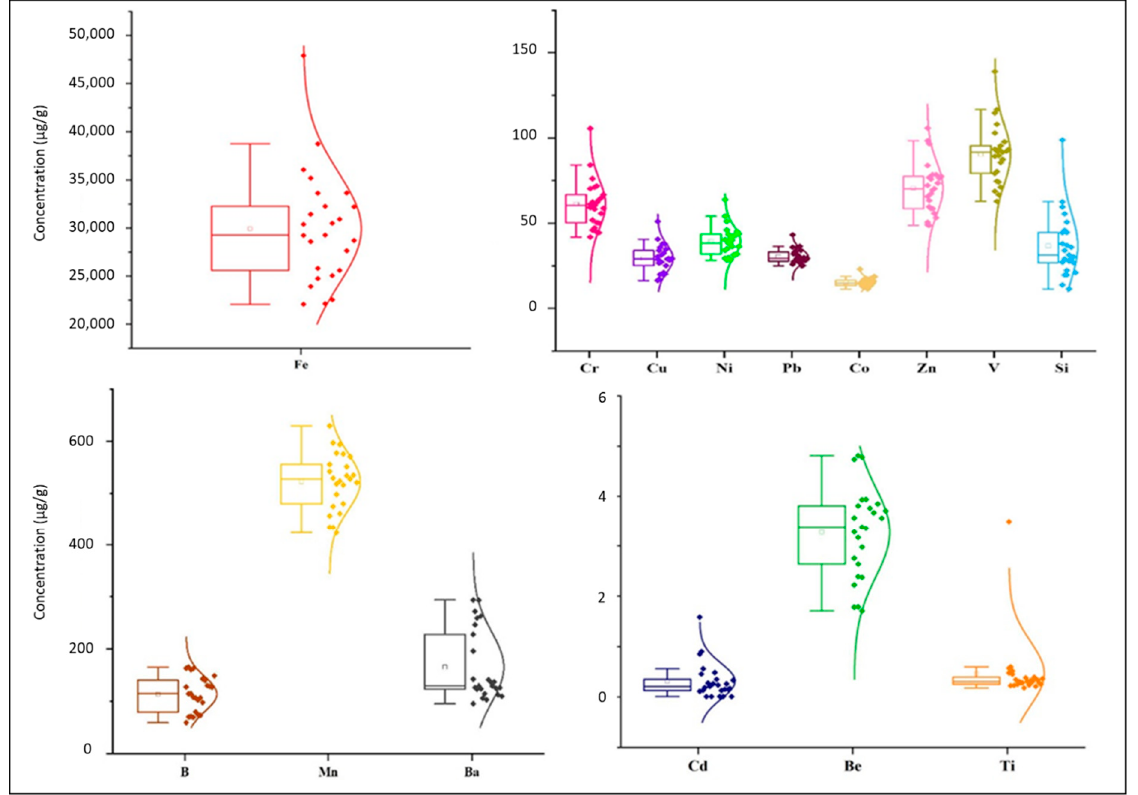
Figure 3. Box and half-violin plot exhibiting concentrations of trace elements. The central bar in the box displays the median value; the end of the whiskers represents the minimum and maximum values. The start and end of the boxes include half the data points between the median and extreme of range.